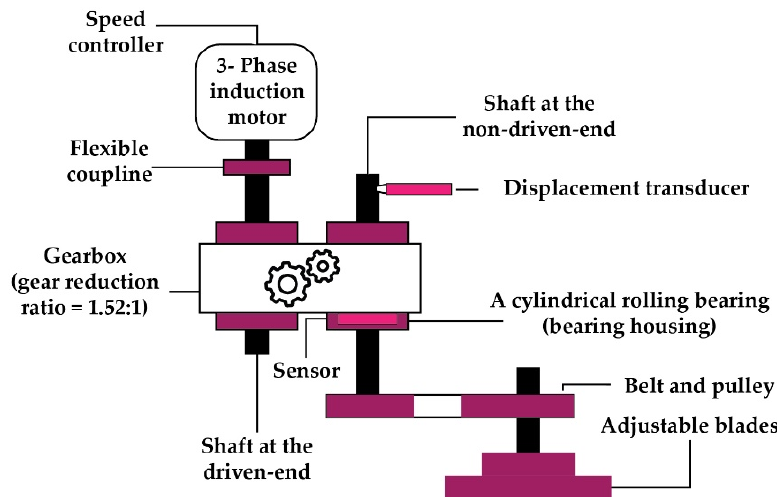
Figure 6. Schematic diagram of the self-designed testbed.